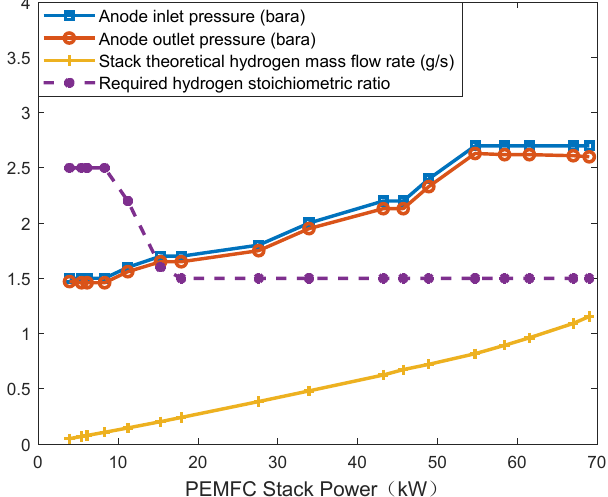
Figure 1. H 2 inlet and outlet pressure, mass flow rate, and stoichiometric ratio.